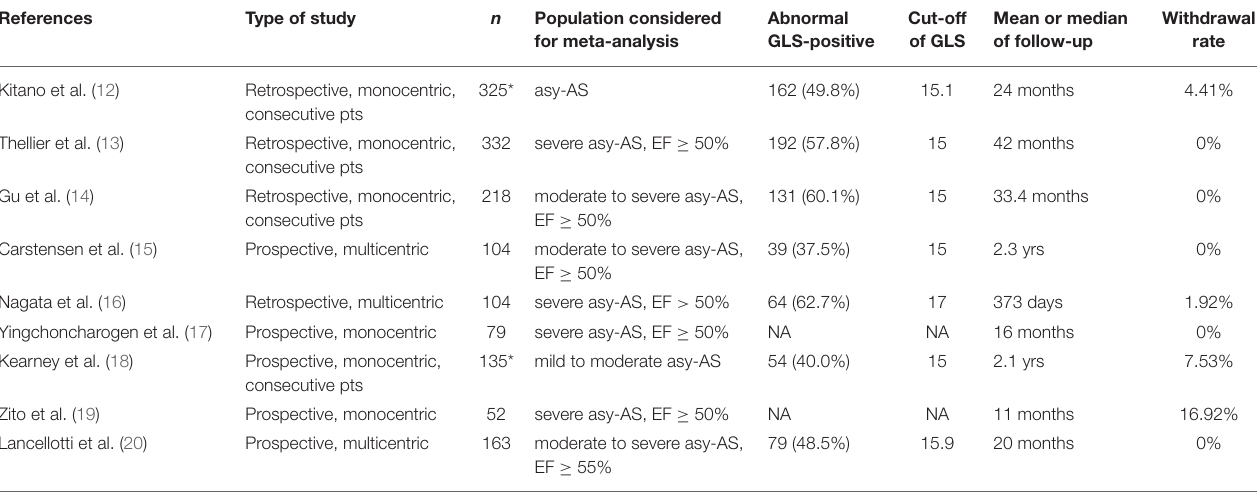
TABLE 1 | Description of studies included in meta-analysis.